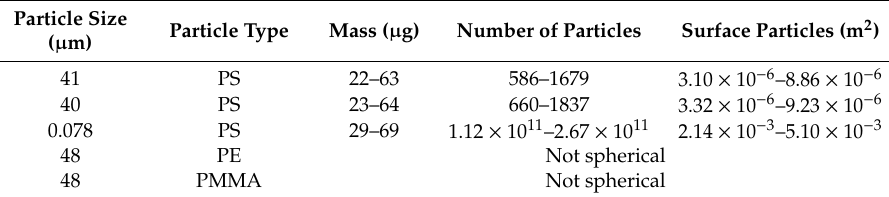
Table 3. Mass and number of polystyrene